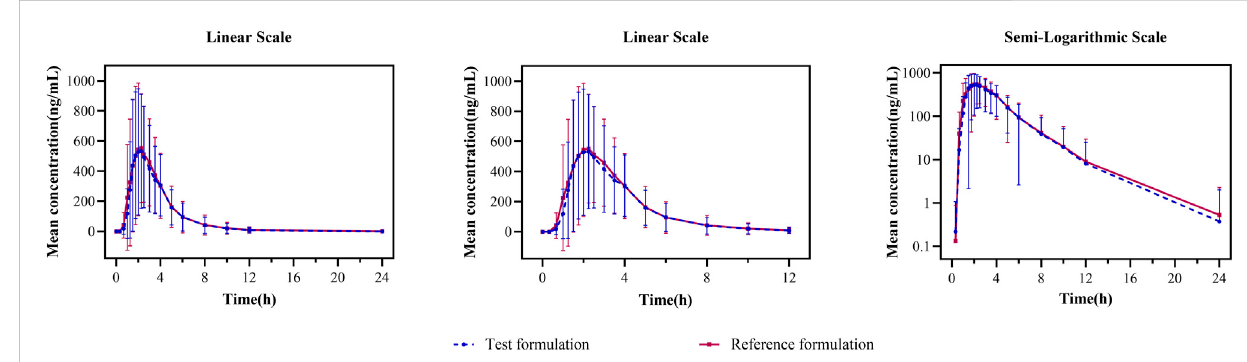
FIGURE 2 Mean plasma concentration – time curves for the test and reference formulations after a single dose of 20 mg of the esomeprazole enteric-coated tablet in healthy subjects under fasting conditions. N = 32. Bars represent SD. T: test formulation; R: reference formulation.